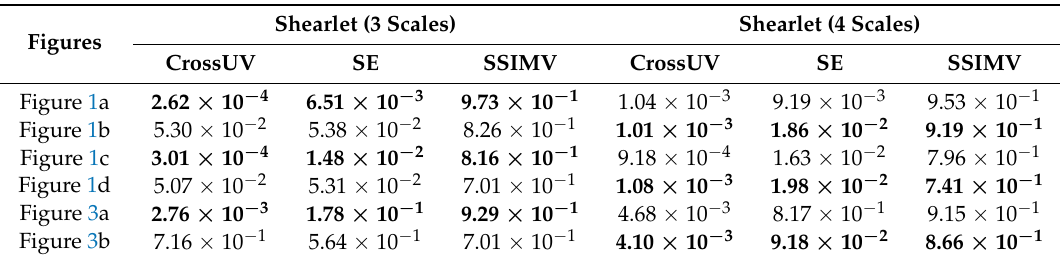
Table 2. CrossUV, SE and SSIMV computed from the decomposed simulated and experimental fringe patterns by Shearlet transform method with different parameter values. The optimal values are marked in